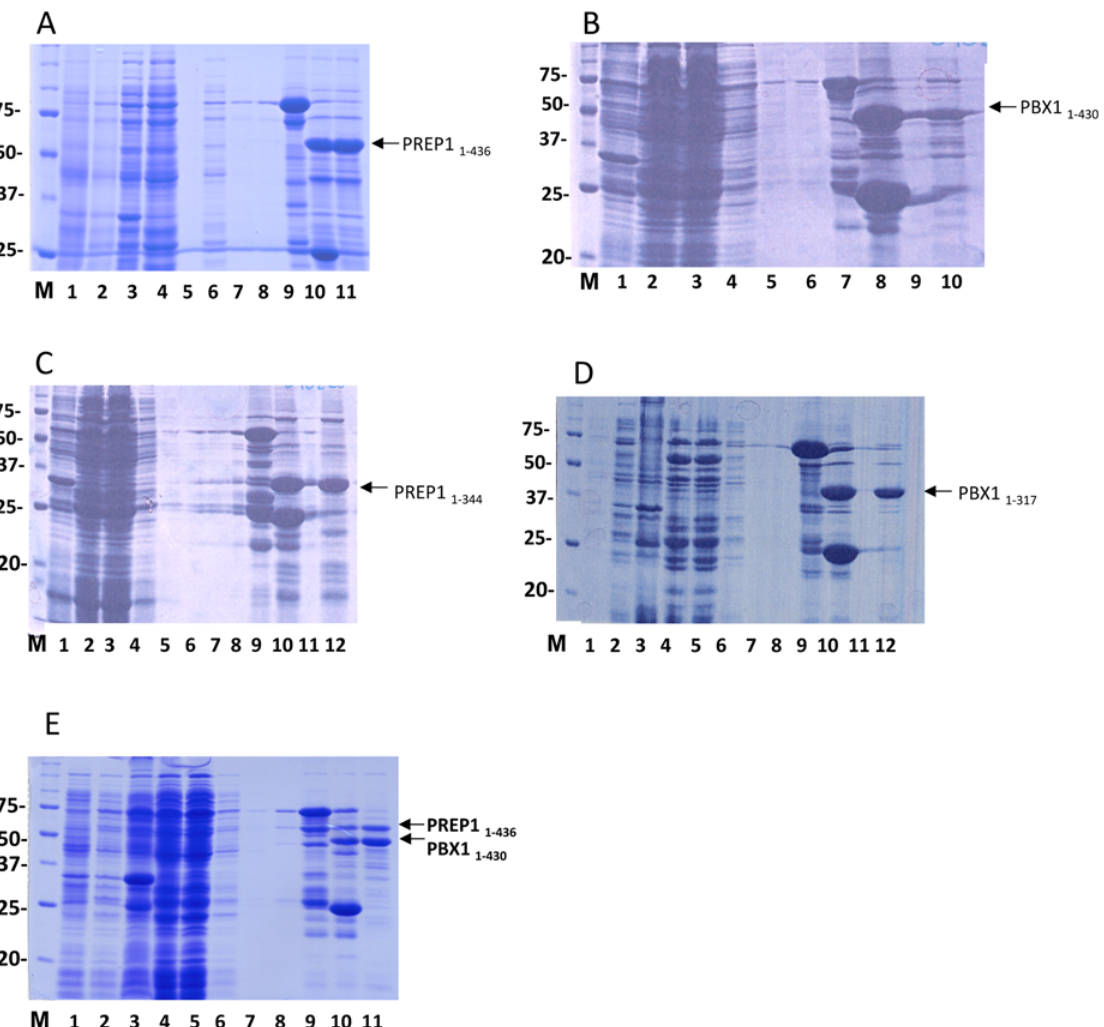
Fig 2. Expression and purification of recombinant PREP1 and PBX1. A. Expression and purification of full-length PREP1. SDS PAGE analysis of proteins at different purification stages. Lane M, Bio-Rad size standard; Lane 1, total lysate before IPTG induction; Lane 2, total lysate after IPTG induction; Lane 3, pellet; Lane 4, cleared lysate; Lane 5,empty; Lane 6, first wash after incubation with glutathione beads (Tris-buffer with 0.5 M NaCl); Lane 7, second wash (Tris-buffer with 0.3 M NaCl); Lane 8, third wash (Tris-buffer with 0.3 M NaCl); Lane 9, glutathione beads before elution; Lane 10; glutathione beads after elution; Lane 11, supernatant from glutathione beads, containing the eluted protein. B. Expression and purification of full-length PBX1. Lane M, Bio- Rad size standard; Lane 1, total lysate before IPTG induction; Lane 2, total lysate after IPTG induction; Lane 3, cleared lysate; Lane 4, flow-through after incubation with glutathione beads; Lane 5, first wash (Tris-buffer with 0.5 M NaCl); Lane 6, second wash (Tris-buffer with 0.3 M NaCl); Lane 7, glutathione beads before elution; Lane 8; glutathione beads after elution; Lane 9, empty; Lane 10, supernatant from glutathione beads, containing the eluted protein. C. Expression and purification of PREP1 1 – 344 . Lane M, Bio-Rad size standard; Lane 1, total lysate before IPTG induction; Lane 2, total lysate after IPTG induction; Lane 3, cleared lysate; Lane 4, flow-through after incubation with glutathione beads; Lane 5, first wash (Tris-buffer with 0.5 M NaCl); Lane 6, second wash (Tris-buffer with 0.3 M NaCl); Lane 7, third wash (Tris-buffer with 0.3 M NaCl); Lane 8, empty; Lane 9; glutathione beads before elution; Lane 10, glutathione beads after elution; Lane 11, empty; Lane 12, supernatant from glutathione beads, containing the eluted protein. D. Expression and purification of PBX1 1 – 317 . Lane M, Bio-Rad size standard; Lane 1, total lysate before IPTG induction; Lane 2, total lysate after IPTG induction; Lane 3, pellet; Lane 4, cleared lysate; Lane 5, flow-through after incubation with glutathione beads; Lane 6, first wash (Tris-buffer with 0.5 M NaCl); Lane 7, second wash (Tris-buffer with 0.3 M NaCl); lane 8, third wash (Tris-buffer with 0.3 M NaCl); Lane 9, glutathione beads before elution; Lane 10, glutathione beads after elution; Lane 11, empty; Lane 12, supernatant from glutathione beads, containing the eluted protein. E. Co-expression and purification of GST-PBX1 1 – 430 PREP1 1 – 436 . Lane M, Bio-Rad size standard; Lane 1, total lysate before IPTG induction; Lane 2, total lysate after IPTG induction; Lane 3, pellet; Lane 4, cleared lysate; Lane 5, flow-through after incubation with glutathione beads; Lane 6, first wash (Tris-buffer with 0.5 M NaCl); Lane 7, second wash (Tris-buffer with 0.3 M NaCl); Lane 8, third wash (Tris-buffer with 0.3 M NaCl); Lane 9, glutathione beads before elution; Lane 10, glutathione beads after elution; Lane 11, supernatant containing the eluted proteins.